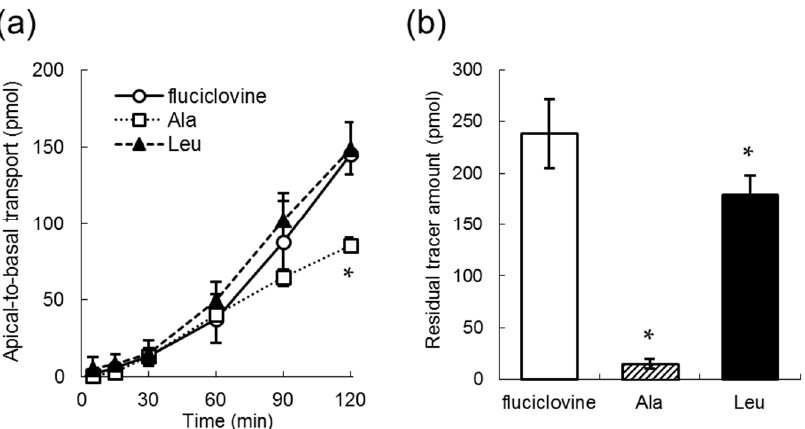
Figure 2. ( a ) Time course of 14 C-labeled amino acid (10 μ M) transport through the LLC-PK1 monolayers after 4–5 days culture ( n = 3–6); ( b ) the residual amount of intracellular amino acid tracer at 120 min ( n = 3–6); “fluciclovine”, “Ala”, and “Leu” indicate “[ 14 C]fluciclovine”, “ L -[ 14 C]alanine”, and “ L -[ 14 C]leucine”, respectively. Each data point represents the mean ± SD. * p < 0.05 vs. fluciclovine.